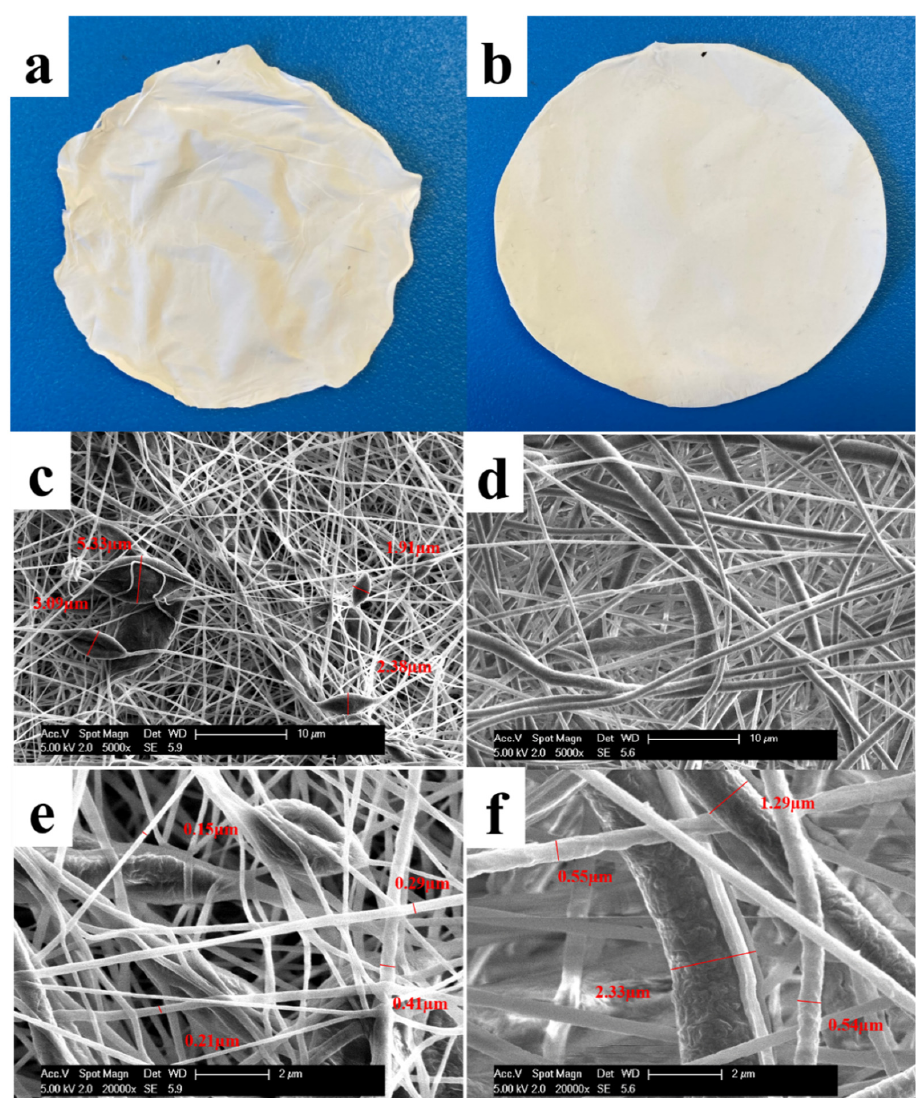
Figure 2. The macroscopic appearances of ( a ) a 5% PCL membrane and ( b ) a 10% PCL membrane. The SEM images of ( c ) 5% PCL nanofibers and micro-beads observed at 5000× magnification with some of the micro-beads measured for the widths, ( d ) 10% PCL nanofibers at 5000× magnification, ( e ) 5% PCL nanofibers and micro-beads at 20,000× magnification with some of the fibers measured for the diameters, ( f ) 10% PCL nanofibers at 20,000× magnification with some of the fibers meas- ured for the diameters.